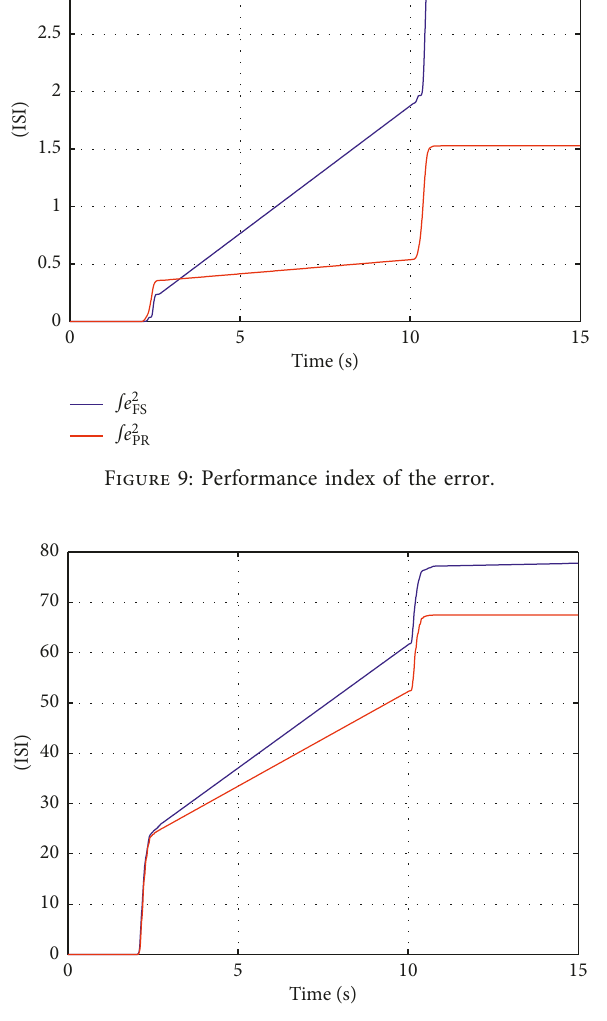
Table 1: Parameters